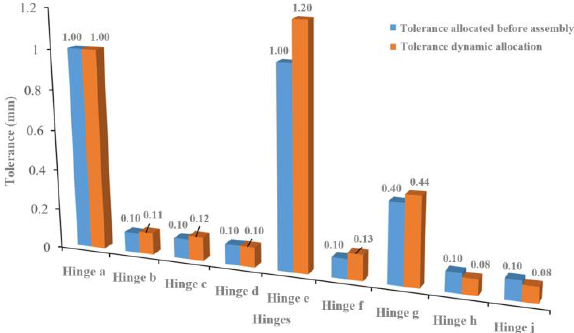
Figure 18. The tolerance allocation results of different methods.